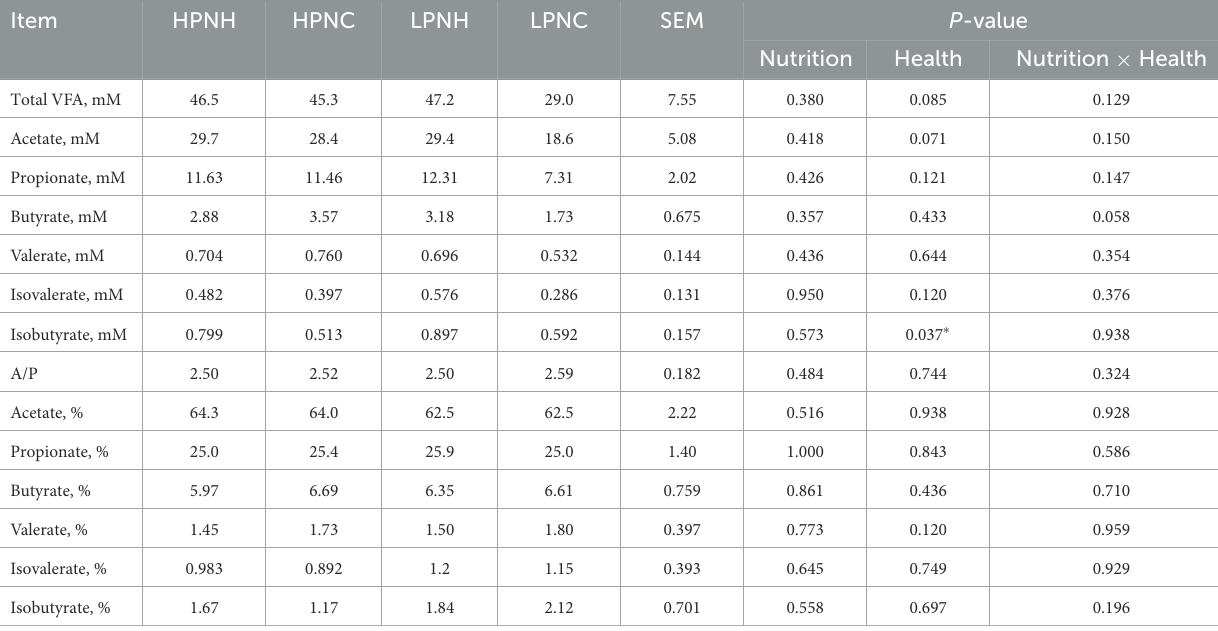
TABLE 2 Volatile fatty acid profiles of lambs in response to the plane of nutrition and health